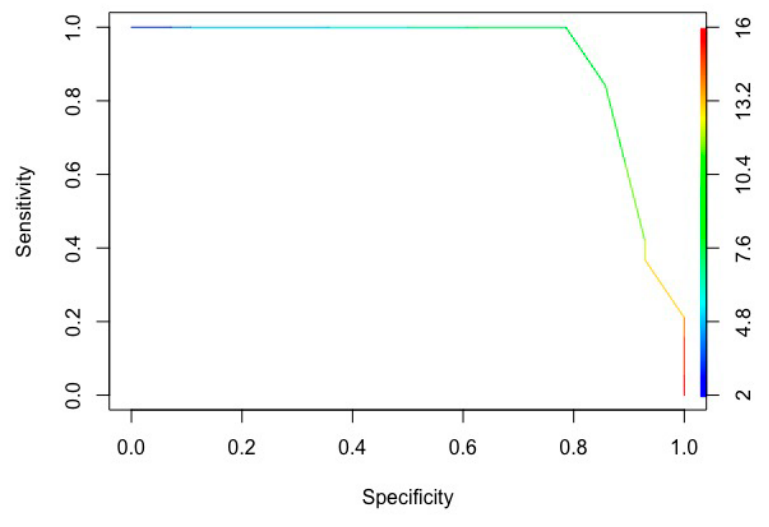
Figure 5. ROC curve of the CoMiSS TM score.